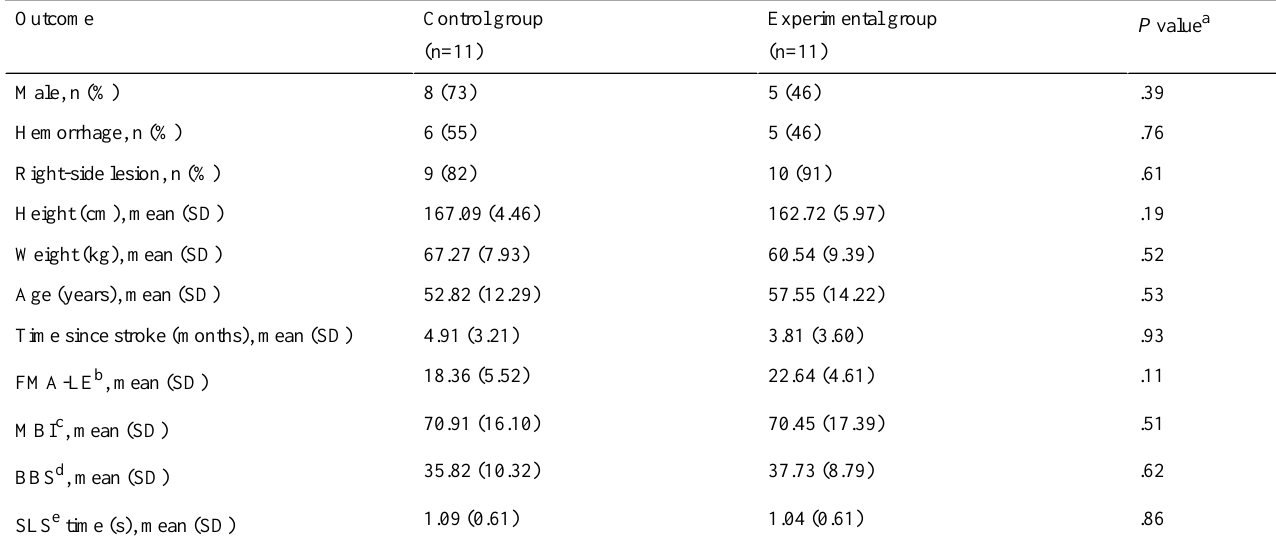
Table 3. Baseline characteristics of the patients with stroke